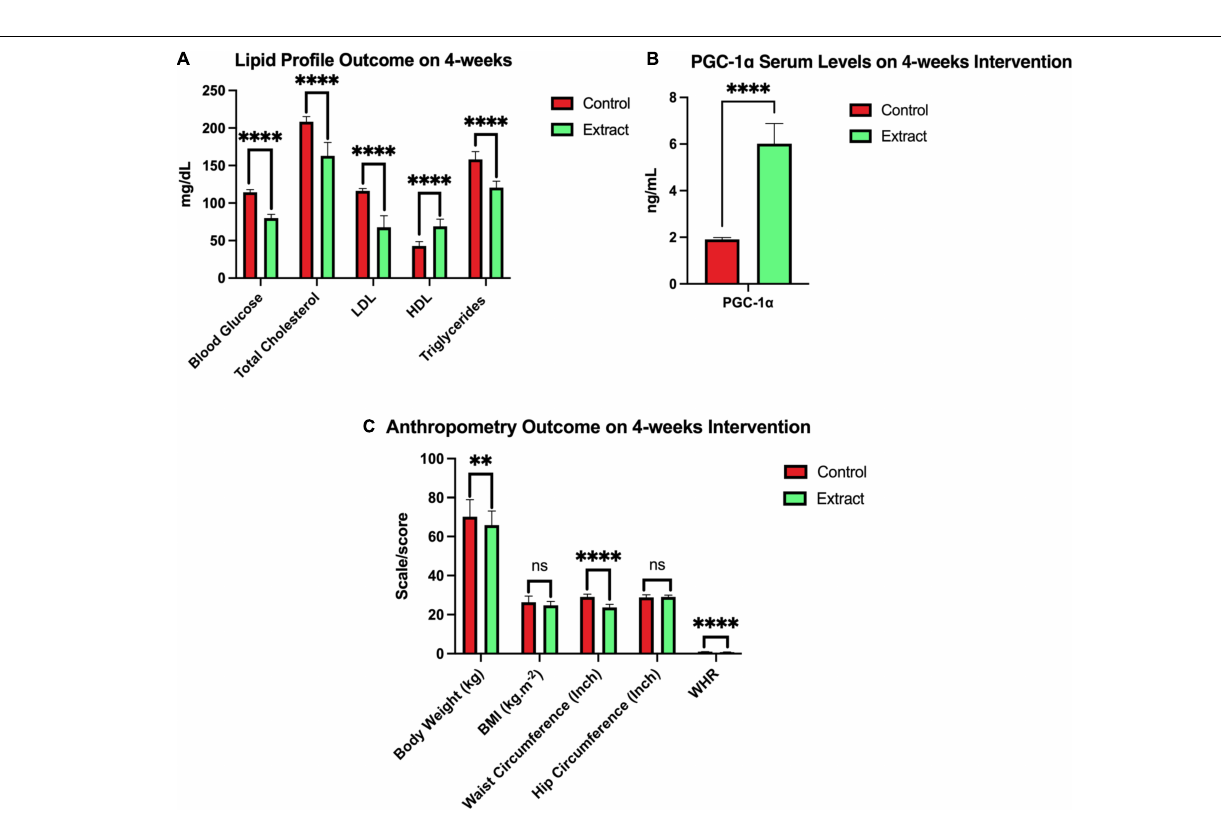
FIGURE 5 | Outcome after 4 weeks of sea grapes extract supplementation. In this figure, there were three groups (A-C) . Group A showed a significant value of the lipid profile (blood glucose, total cholesterol, LDL, HDL, and triglycerides) between placebo (control) groups and extract (sea grapes antioxidant). Group B showed a significant value over the control group with the extract group 4 weeks of the intervention. Group C showed a significant value of the anthropometry profile at week 4 of the intervention between placebo or control groups and extract. ns p > 0.05; ∗∗ p = 0.026; ∗∗∗∗ p < 0.0001. The above values are presented in the form of mean ±